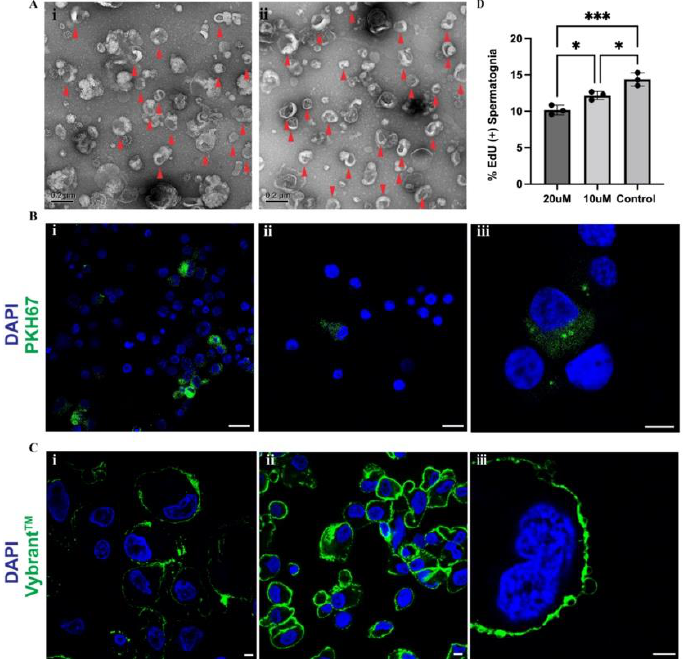
Figure 6. Sertoli cell-released exosomes increase spermatogonial proliferation: ( A ) Identification of Sertoli cell-isolated exosomes (red arrows) by size using TEM at 25k magnification. ( B ) Co-culture of PKH67-tagged extracellular vesicles and spermatogonia. Tagged extracellular vesicles are taken up by spermatogonia in contact ( i , iii ), and separated from vesicles with transwells ( ii ). ( C ) Visualization of lipid rafts on Sertoli cells that had been cultured alone for seven days ( i ), and from Sertoli cells that had been co-cultured with spermatogonia for seven days ( ii , iii ). ( D ) Proliferation rates of spermatogonia grown on Sertoli cell feeders treated with 10 µM of GW4869, 20 µM of GW4869, or an equivalent percentage of DMSO (control). Data are presented as mean ± SD (n = 3). A p -value of < 0.05 was considered significant (* p ≤ 0.05, *** p ≤ 0.001). TEM scale bars = 0.2 µm ( A ), Confocal scale bars = 25 µm ( B )( i , ii ), and 8 µm ( B )( iii ), and 10 µm ( C ).